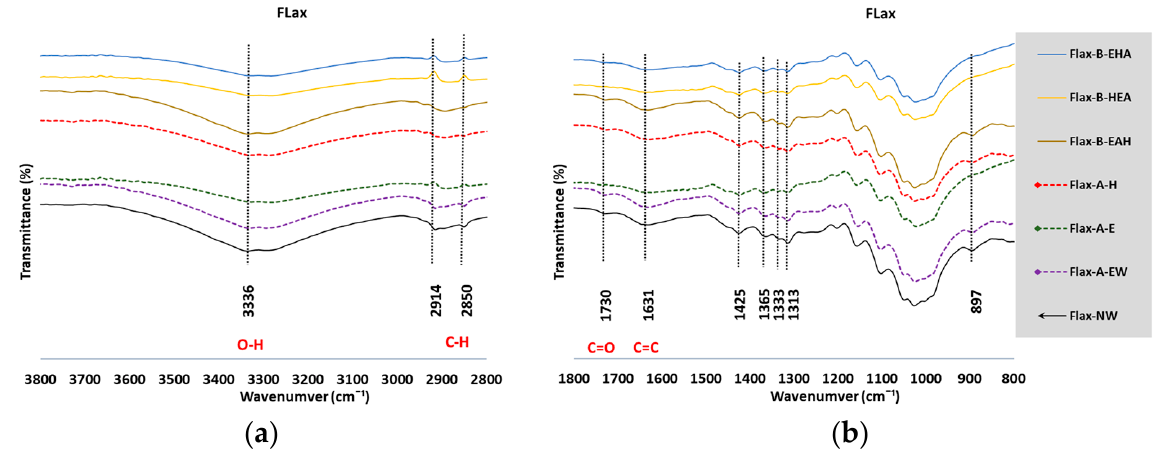
Figure 3. FTIR spectra of flax fibers before washing (NW) and after washing (B-EHA, B-HEA, A-E, A-H, B-EAH, A-EW). ( a ) Range 2800–3800 cm − 1 , ( b ) range 800–1800 cm − 1 .